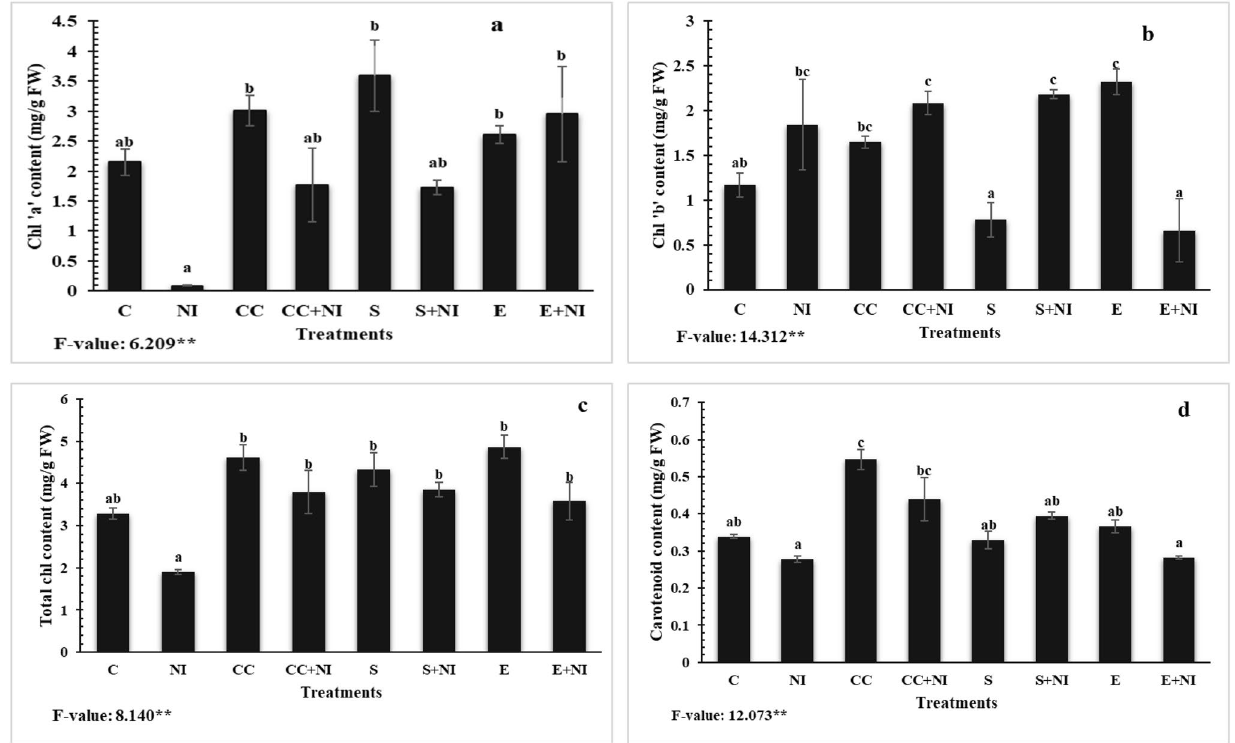
Figure 2. ( a-d ) Photosynthetic pigments ( a ) Chlorophyll ‘a’ content; ( b ) Chlorophyll ‘b’ content; ( c ) Total chlorophyll content; ( d ) Carotenoid content in M. incognita inoculated 60 days old tomato plants treated with S. hydrogenans strain DH-16. Different treatments are represented as C (control), NI (nematode inoculated), CC (culture cells), CC + NI (culture cells + nematode inoculated), S (supernatant), S + NI (supernatant + nematode inoculated), E (crude extract), E + NI (crude extract + nematode inoculated). Results are given in mean ± standard error and F-value ** indicates significance at p ≤ 0.01 as per Tukey’s test. Different letters a, b, c represents significant difference among treatments and same letters represent no significant